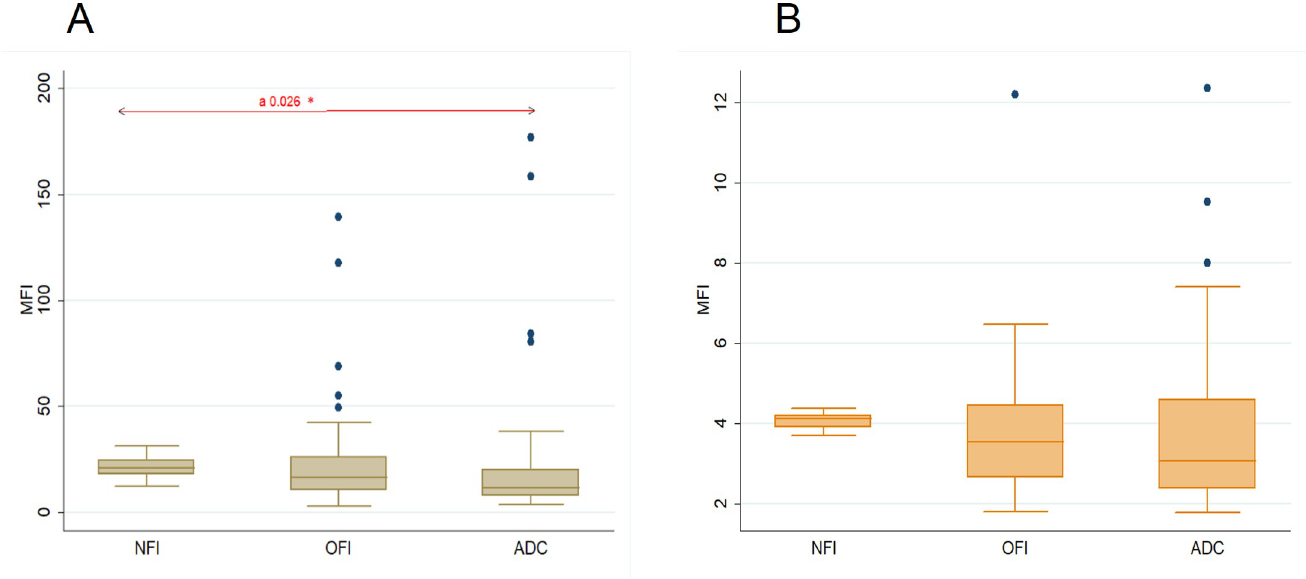
Fig 1. Comparison of MFI among different groups on day of admission (A) DC-SIGN (CD209) (B) FC U R2A (CD32). (DOA–Day of Admission, Dengue—All Dengue Cases, NFI- Non Febrile Illness, OFI- Other Febrile Illness) � p value < 0.05 –statistical significance Statistical Test: Kruskal Wallis Rank test a- Indicates statistical significance between all groups on day of